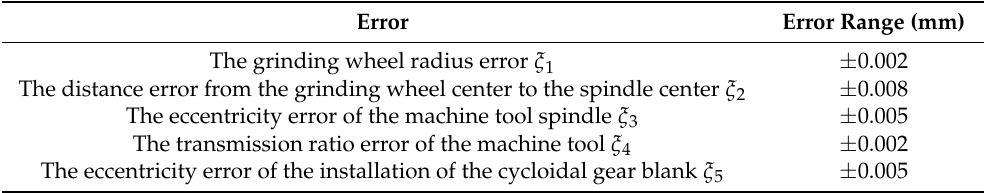
Table 2. Cycloidal gear design parameters. Table 3. Cycloidal gear machining error.